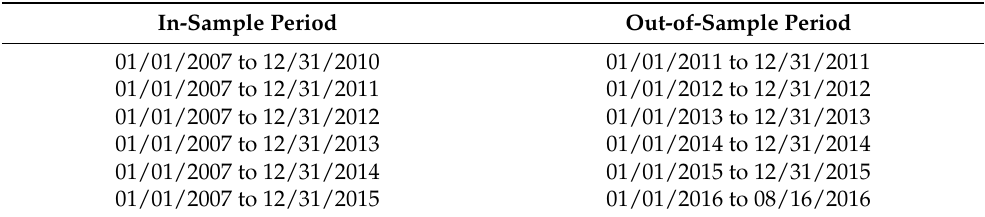
Table 4. In-sample and out-of-sample